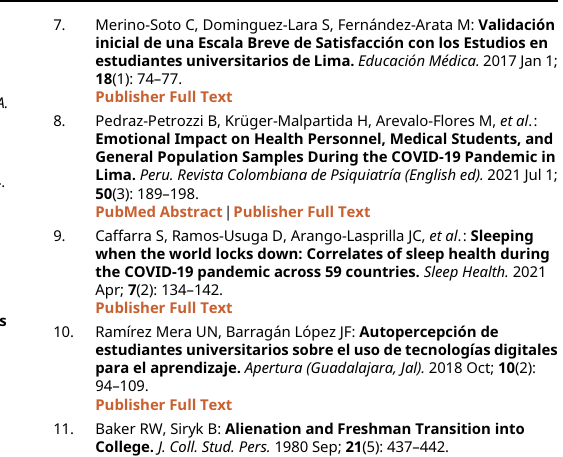
Figshare: “ Online academic satisfaction during the COVID-19 pandemic in medical students: role of sleep, emotions, college adjustment, and digital skills